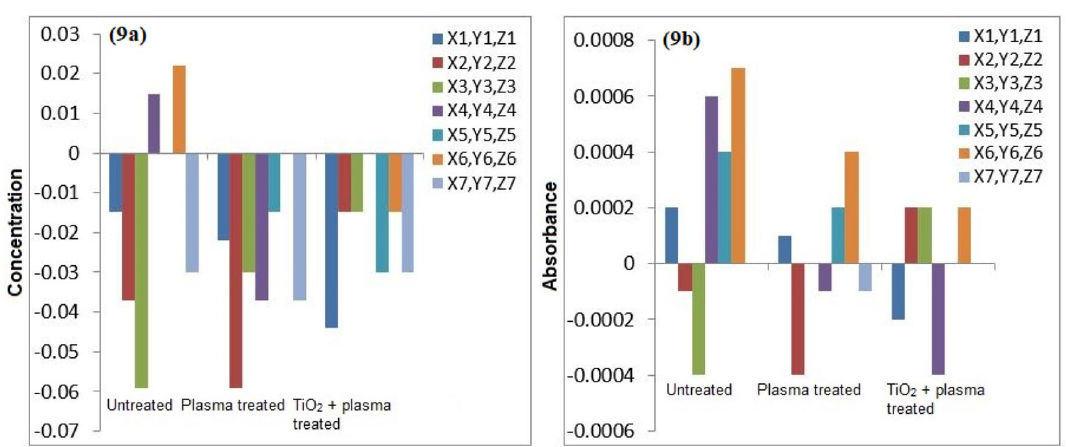
Figure 9. ( a ) Comparison of Pb concentration (mg/l), ( b ) Comparison of Pb absorbance